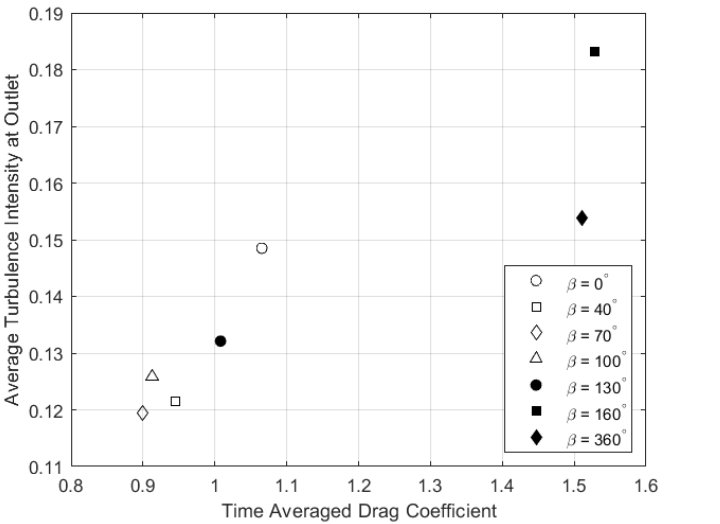
Figure 9. Variation in average turbulence intensity at the outlet with the time-averaged drag coeffi- cient at Re = 4.2 × 10 4 , thickness t / D = 14.3% and a porosity of 20